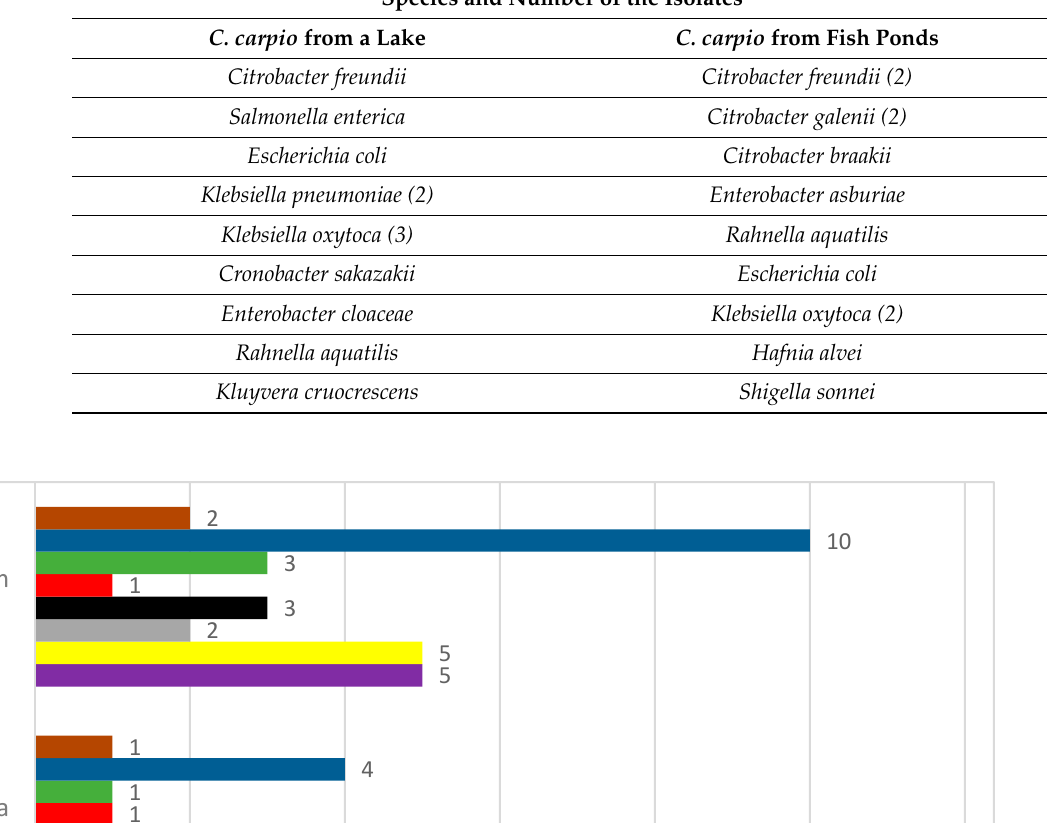
Table 2. Species of Enterobacteriaceae identified from the wild and agricultural carp .